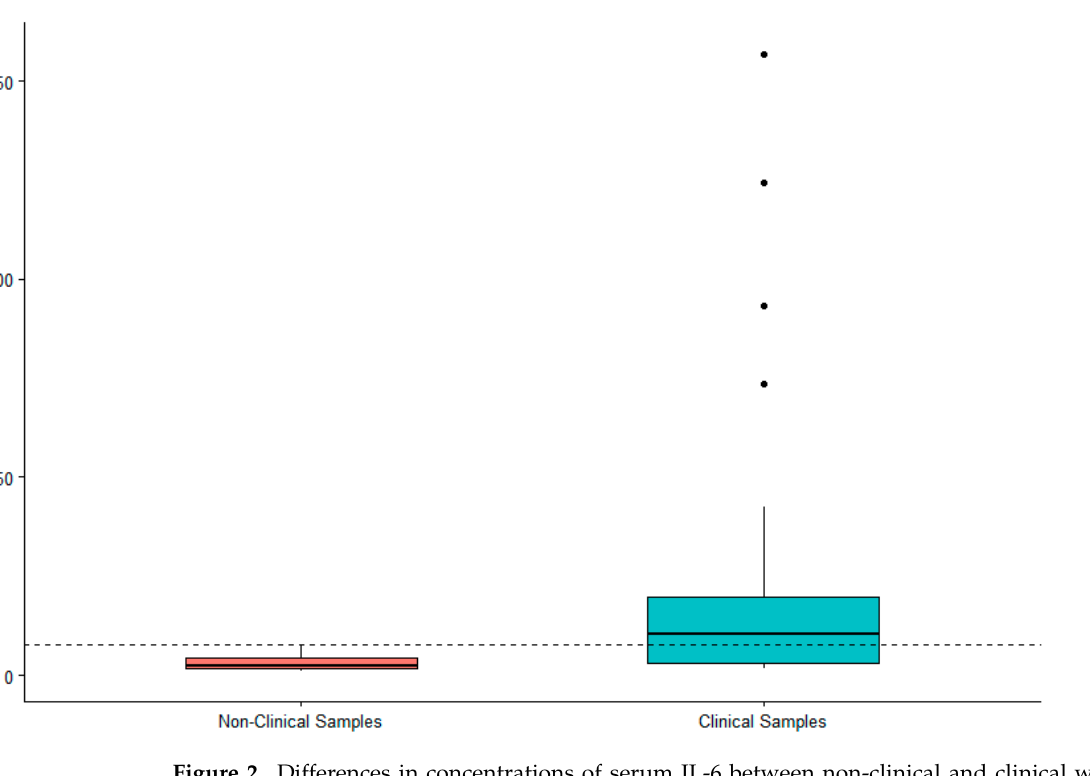
Figure 2. Differences in concentrations of serum IL ‐ 6 between non ‐ clinical and clinical western lowland gorilla ( n = 21) samples ( β = − 1.661, SE = 0.254, p < 0.0001). The calculated upper limit of the species ‐ specific value range is denoted by the dashed horizontal line.